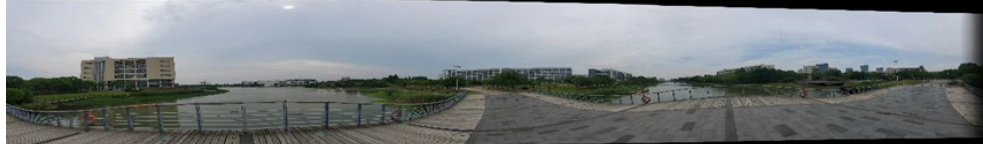
Figure 11. Result obtained by stitching from left to right.